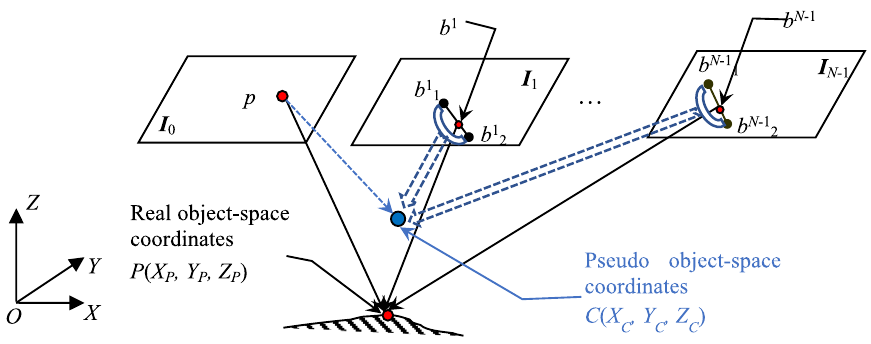
Figure 2. The relation between pixel’s real object-space 3D coordinates and its pseudo object-space